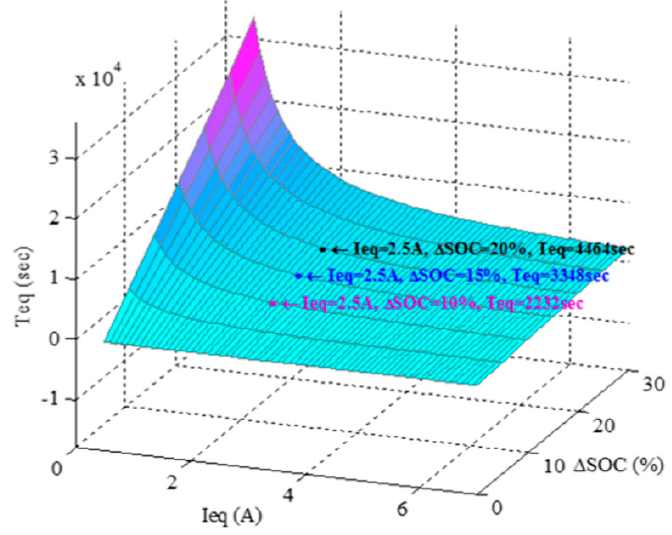
Figure 10. Charge equalization control surface model for battery charge.